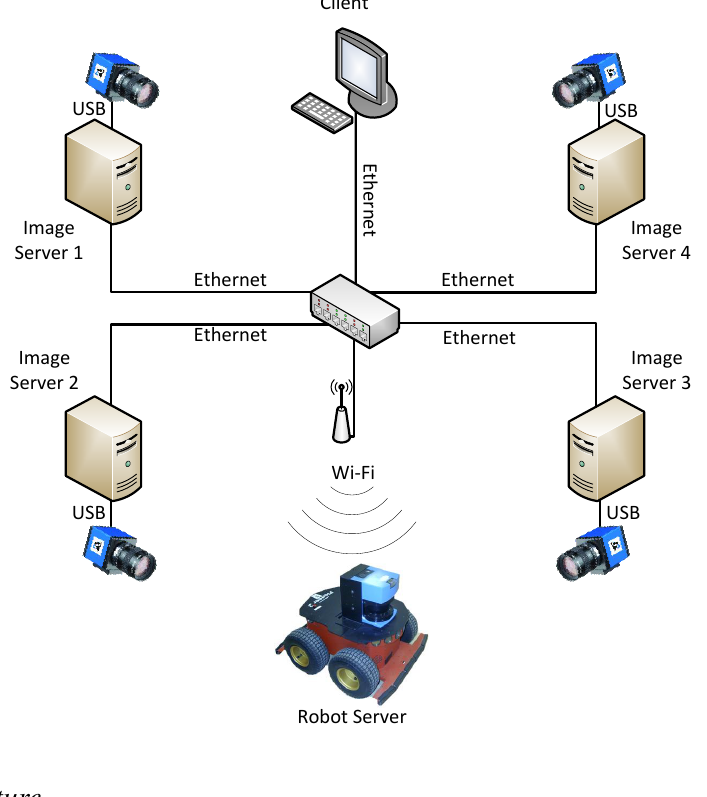
Figure 3. Diagram of hardware/software architecture in the intelligent space at